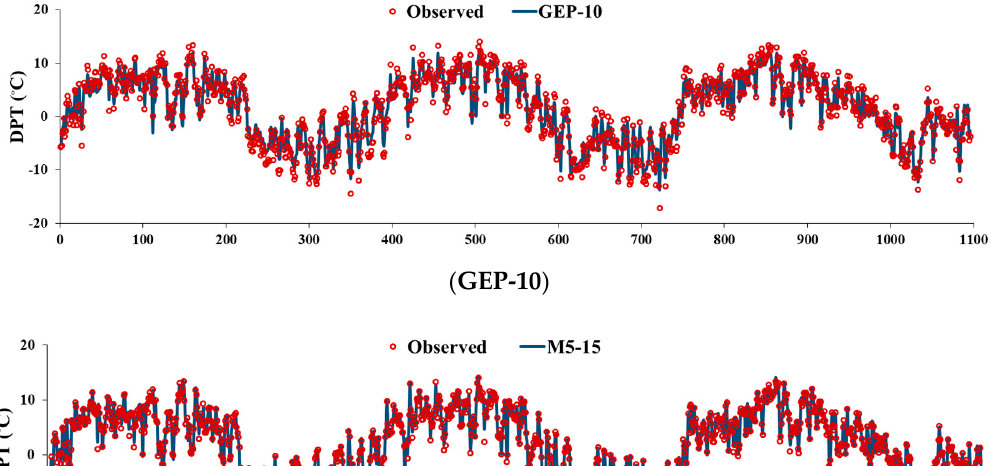
Figure 5. The scatter plots of observed and estimated DPT values with most precise models including ( GEP-10 ), ( M5-15 ), and ( SVR-6 ). It can be comprehended from Table 4 and Figure 4 that the estimation accuracy of the M5-15 was higher than the GEP-10 and SVR-6. The above-mentioned conclusion, regarding the high accuracy of the M5-15 model in estimation the DPT for Tabriz station, can be deduced from Figure 5. In this figure, it can be seen that the distribution of the points around the bisector line in the M5-15 model was less than the corresponding points of GEP-10 and SVR-6.